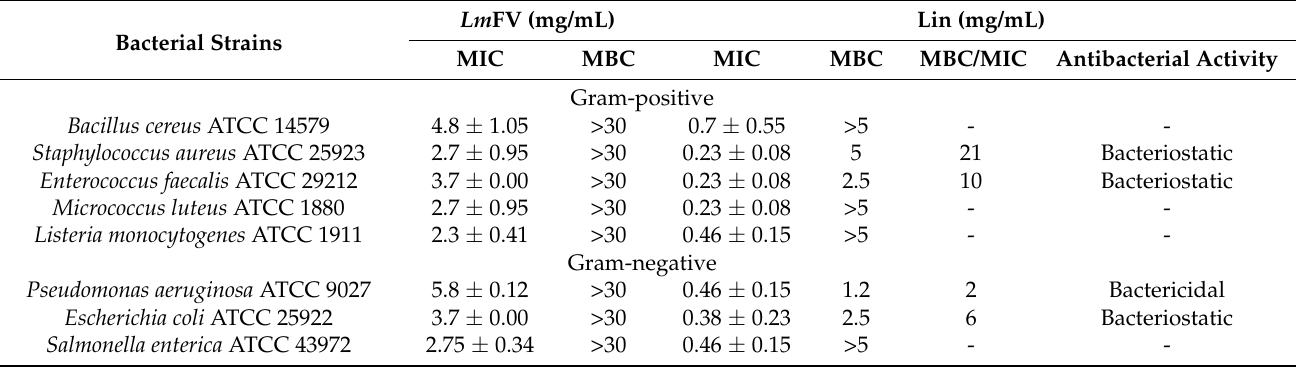
Table 3. Antibacterial activity of Lm FV expressed as minimum inhibitory concentrations (MICs) and minimum bactericidal concentrations